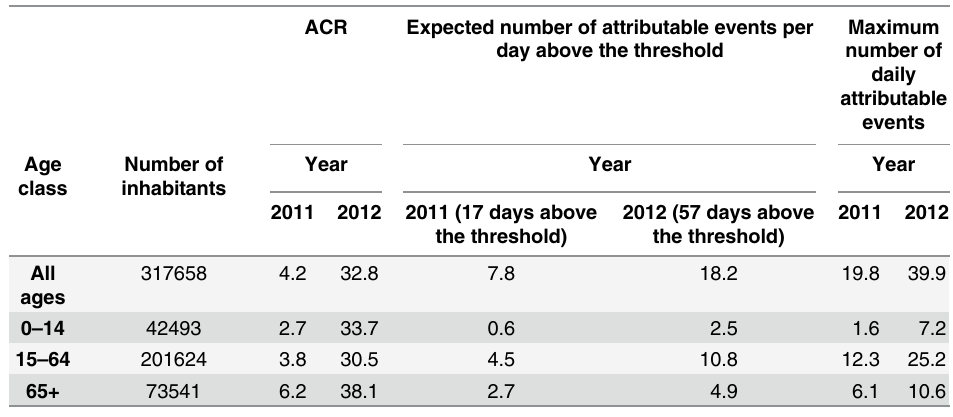
Number of inhabitants in the area under study at the beginning of 2011; median of the attributable community rate (ACR) distribution in 2011 and 2012; expected number of attributable events per day with apparent temperature above the threshold; maximum daily number of attributable no-white tag visits. All results refer to lag 0 – 3